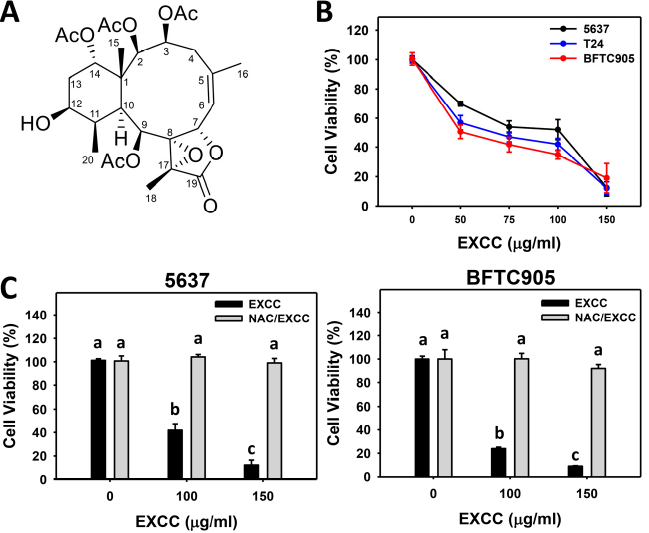
Figure 1. Proliferation change by EXCC. ( A ) Structure. ( B ) ATP assay of EXCC. Three bladder cancer cell lines (5637, BFTC905, and T24) were tested. Cells were treated with control (0.1% DMSO) and EXCC for 48 h and subjected to an ATP assay to determine cell viability. ( C ) ATP assay of NAC/EXCC. N -acetylcysteine (NAC)/EXCC is the NAC pretreatment (10 mM, 1 h) coupled with EXCC posttreatment (100 and 150 μ g/mL, 48 h). Statistical lower-case letters were given to each treatment. Non-overlapping letters between different treatments indicate significant results ( p < 0.05). Data, means ± SD ( n = 3). For example (5637 cells in Figure 1C), the EXCC (black color) 0, 100, and 150 indicating “a, b, and c” show significant results between each other because these letters were non-overlapping. In contrast, EXCC 0 (black color) and NAC/EXCC (gray color) 0, 100, and 150 indicating “a” show nonsignificant results because these letters